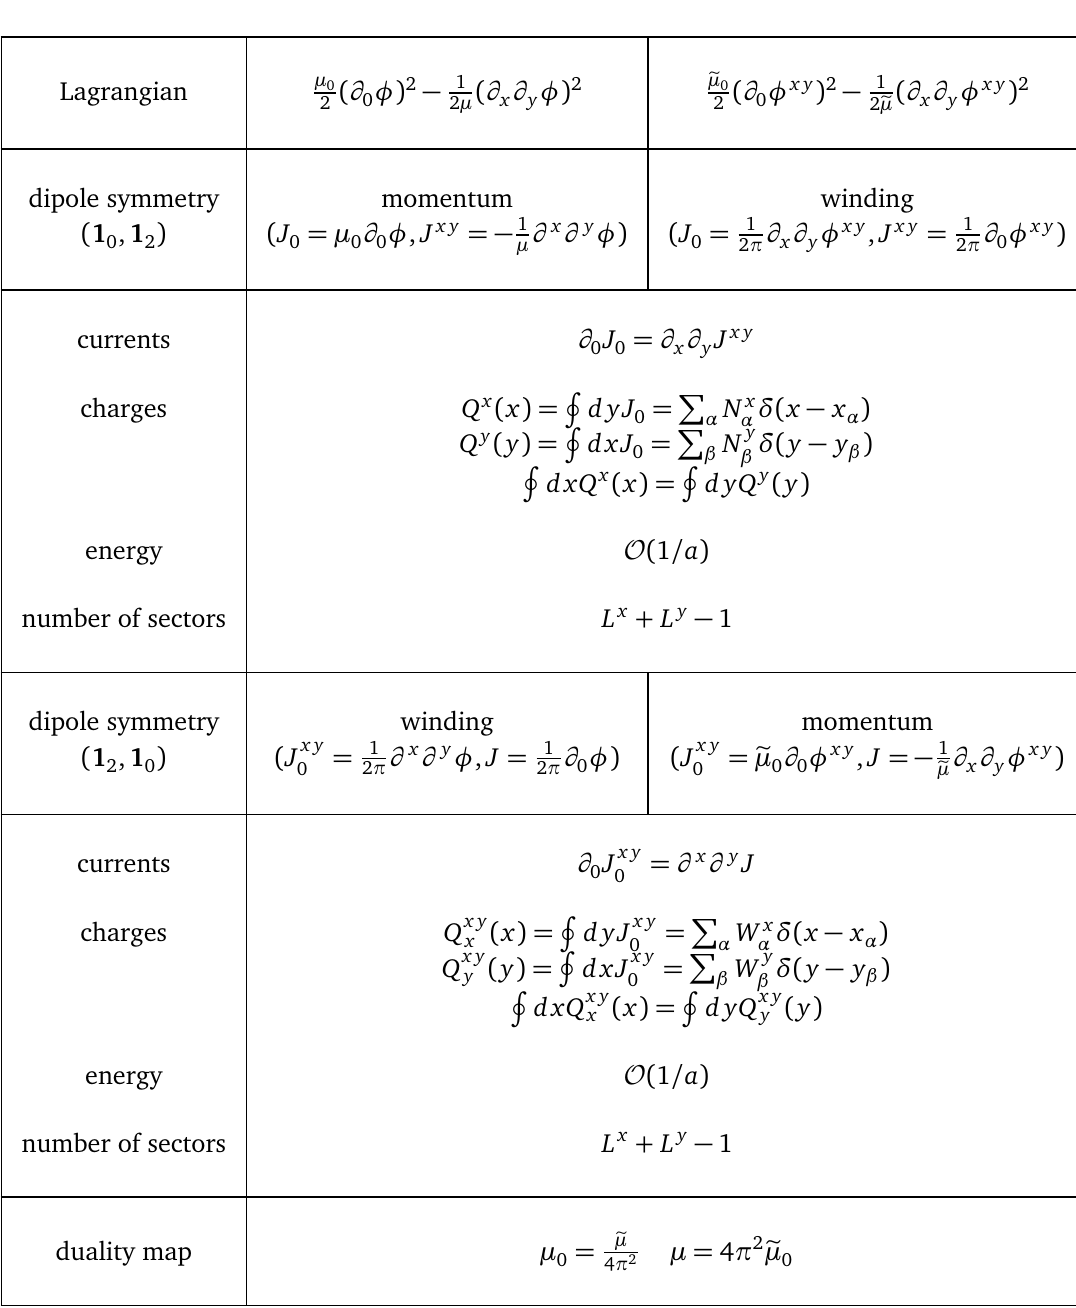
Table 1: Global symmetries and their charges in the 2 + 1-dimensional scalar theories φ and φ x y . The energies of states that are charged under these global symmetries are of order 1 / a . Detailed explanations will be given in the body of the